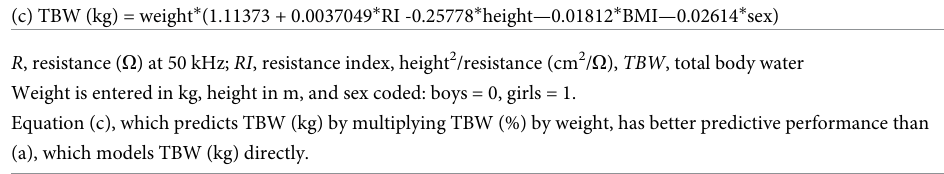
values explain 63.8% of its variance (Table 3). Comparisons of out-of-sample predicted values with measured values and prediction errors, based on a 10-fold split of data, applying the RCV approach, are illustrated in Bland-Altman plots in Figs 2 and 3. For TBW (kg), there was a bias of 0.01 kg (95% limits of agreement -1.34, 1.36) for boys and -0.01 kg (-1.41, 1.38) for girls (Fig 2). For TBW (%), bias for boys was 0.0% (-4.2%, 4.2%) and for girls 0.0% (-3.7%, 3.7%) (Fig 3).